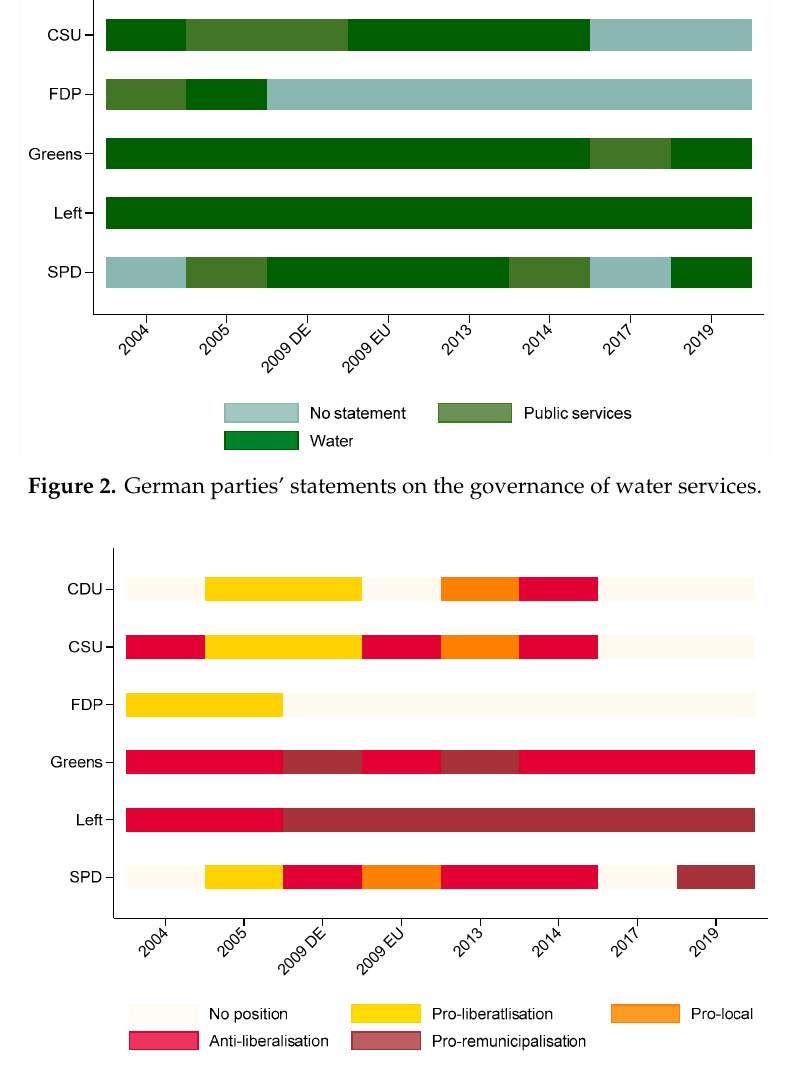
Figure 3. German parties’ positions on the governance of water services.